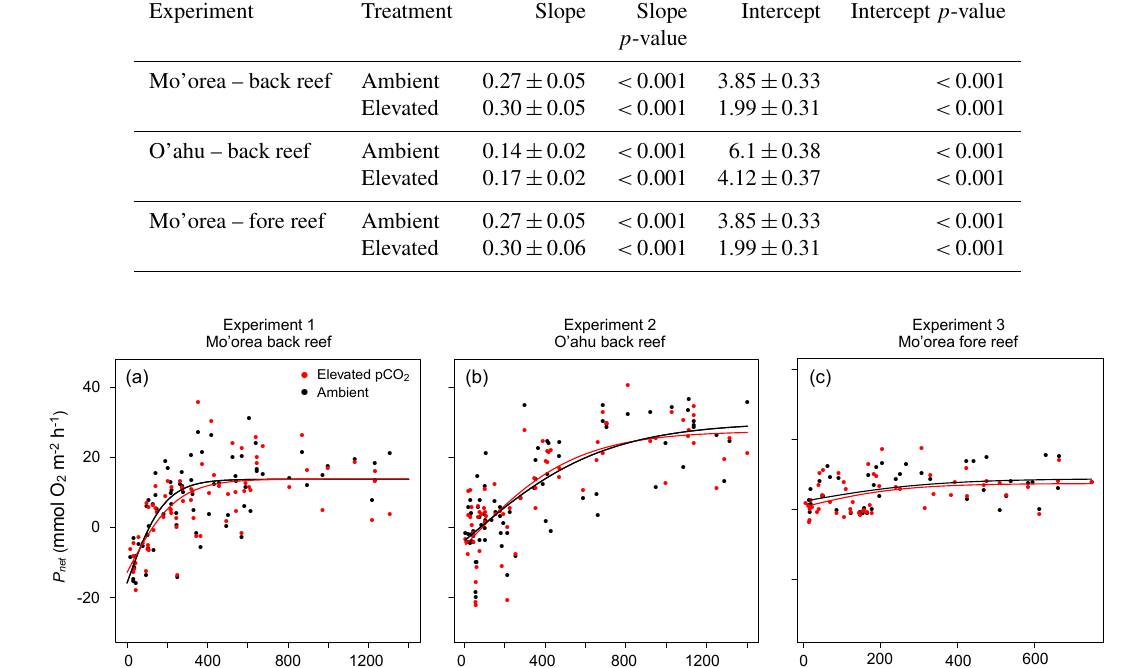
Figure 2. Relationships of net primary production ( P net ) in the light with PAR in three coral reef communities representing the back reef of Mo’orea (a) , the back reef of O’ahu (b) , and the fore reef of Mo’orea (c) . Communities were incubated under ambient p CO 2 ( ∼ 400µatm, black symbols and lines) and elevated p CO 2 ( ∼ 1200µatm, red symbols and lines). The curves represent the best fit of a hyperbolic tangent function for the relationship between P net with